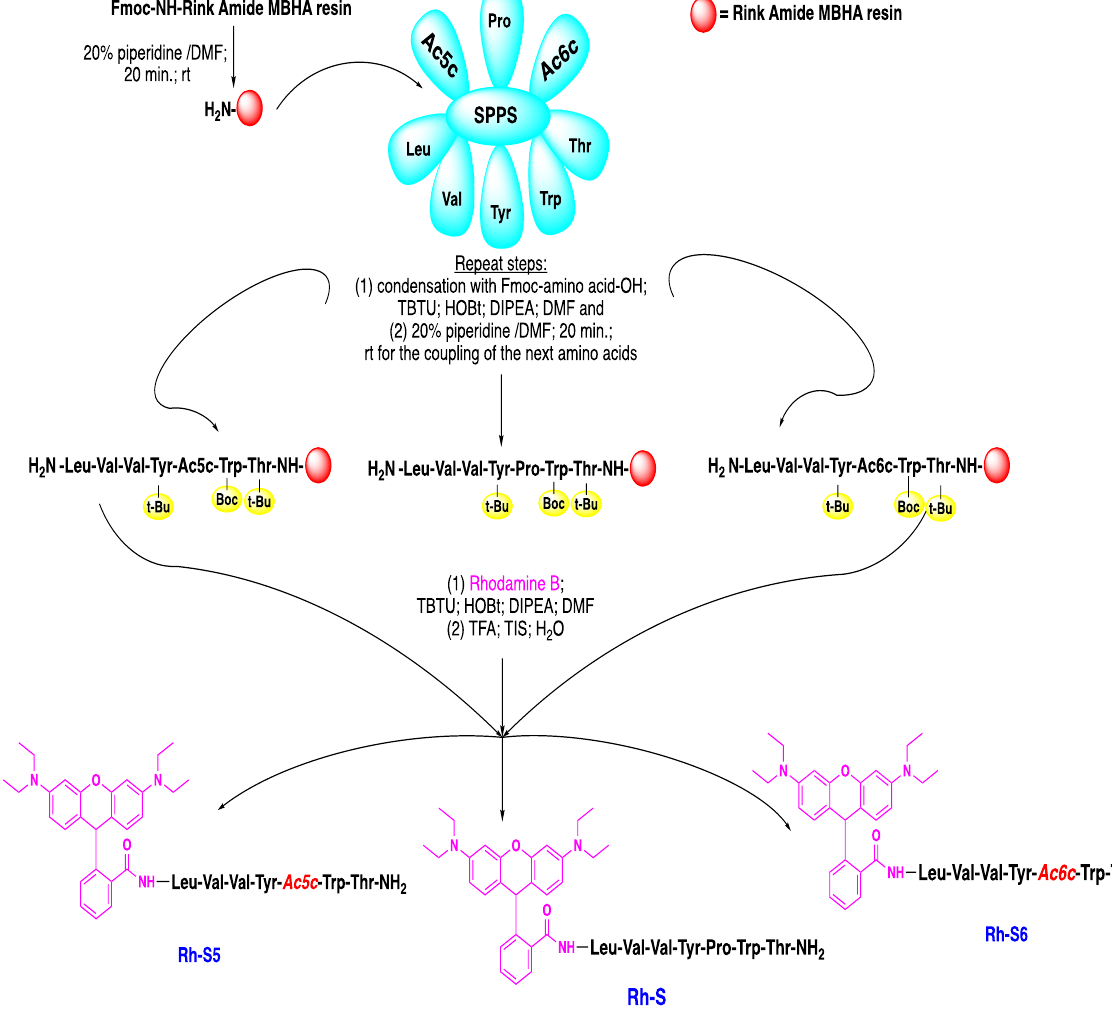
Scheme 1. Schematic presentation of the SPPS – Fmoc chemistry of new spinorphin peptide-based analogs bearing rhodamine B side-chain (Rh-S, Rh-S5, and